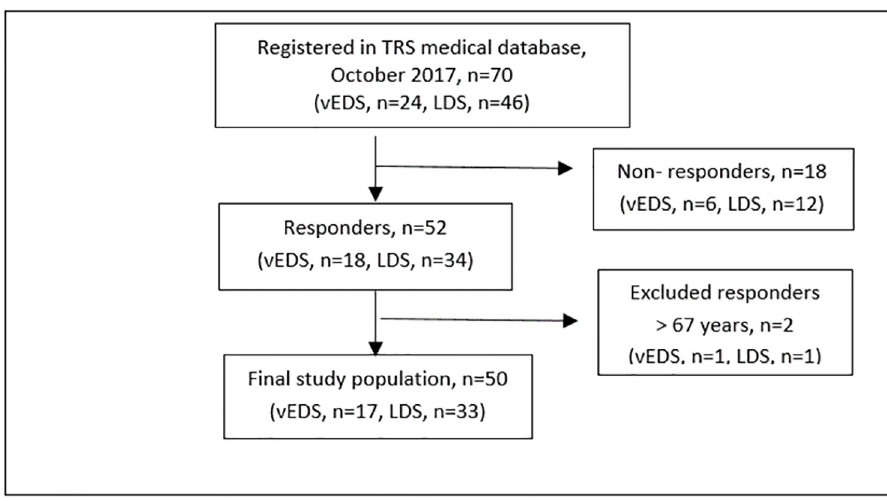
Fig 1. Flowchart of inclusion. Abbreviations: LDS = Loeys Dietz syndrome, vEDS = Vascular Ehlers- Danlos‘syndrome, TRS is a National resource center for rare disorders. Total response rate was 74%, 75% for the vEDS group and 74% for the LDS